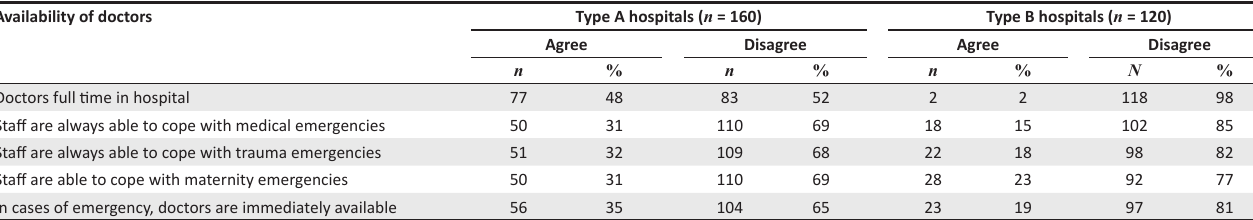
TABLE 2: Availability of